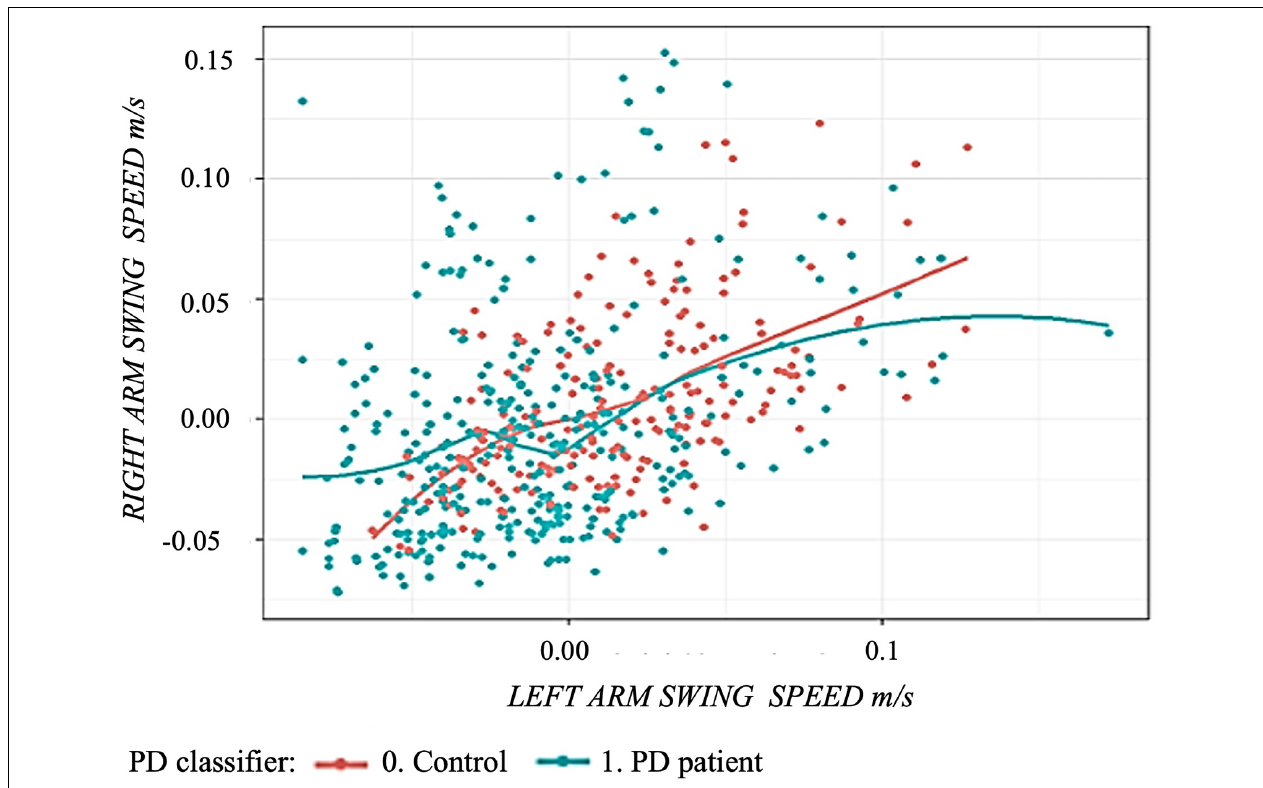
FIGURE 3 | Scatter plot using arm swing speed comparing controls and Parkinson’s disease patients: green curve represents the regression curve of the left and right arms swing speed in Parkinson’s disease patients. The red curve represents the regression curve of the left and right arms swing speed in healthy subjects.